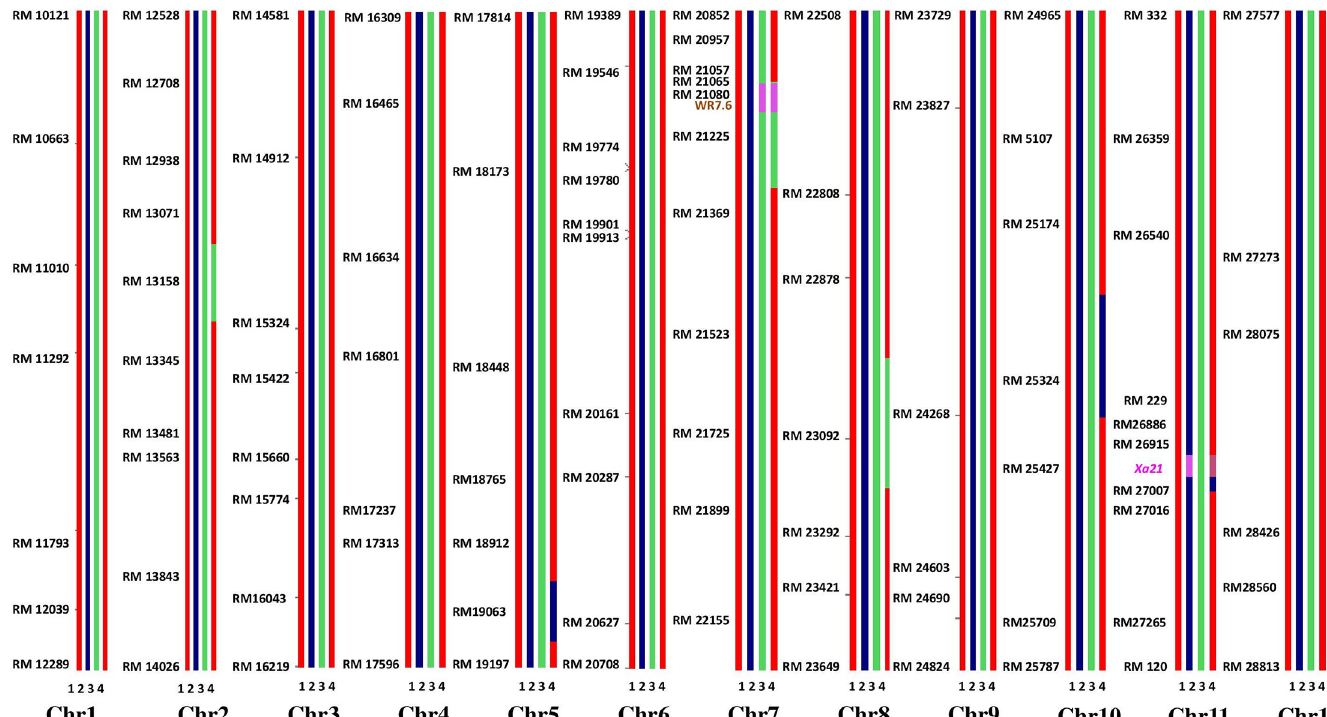
Fig 3. Graphical genotyping representation for the best improved line (IIRRIC102-26-7) of DRR17B. Graphical genotyping representing that the best line of improved two-gene-containing DRR17B line ( Xa21 + Xa33 ), IIRRIC102-26-7 exhibiting the highest genome recovery of the recurrent parent with more than 95%, along with minimum linkage drag on carrier chromosomes 7 and 11, with less than 2 Mb donor parent chromosome (1. DRR17B, 2. ‘ ISM ’, 3. FBR1-15, 4. IIRRIC102-26-7).